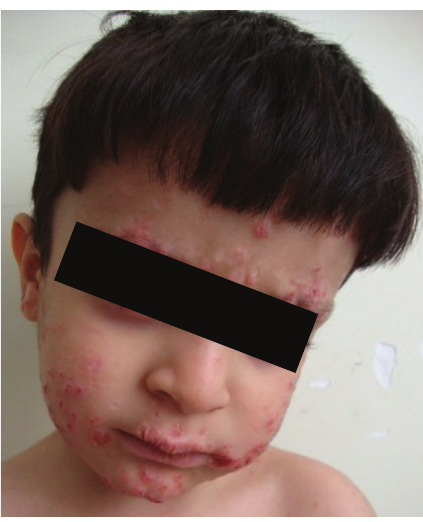
Figure 1: Skin manifestations of keratoacanthoma in hyper IgE syndrome (4 years old).